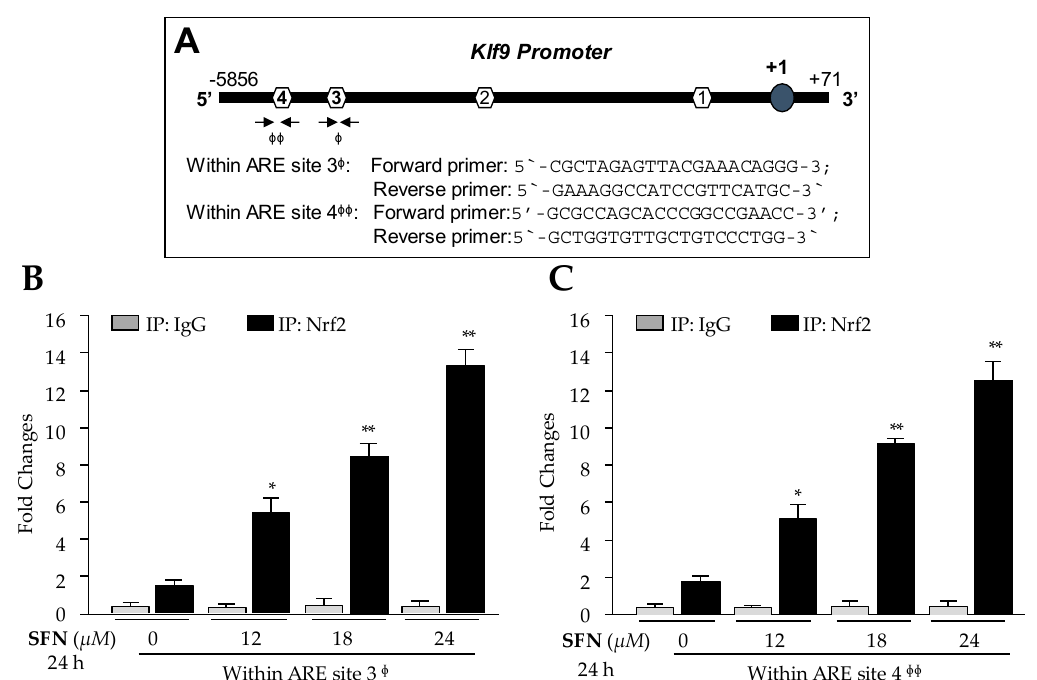
Figure 4. SFN induced increased Nrf2 binding to ARE sites in Klf9 promoter in dose dependent fashion. ( A ) Top panel explaining the presence of four ARE sites in Klf9 promoter and ChIP-qPCR primers containing ARE3 and ARE4. ( B and C ) An in vivo DNA binding assay revealed Nrf2 / ARE interaction. hLECs treated with DMSO control or different concentration of SFN (0, 12, 18 and 24 μ M) for 24 h, as indicated. ChIP assay was carried out with Nrf2 and control IgG antibodies. Pulled DNA fragments were subjected to qPCR analysis. DNA fragments present in the immunoprecipitation were amplified with primers that specifically recognize a fragment of Klf9 promoter containing ARE sites as indicated. As a negative control, ChIP with control IgG was used. * p < 0.05, ** p < 0.001; SFN treated versus DMSO control. Φ and ΦΦ denotes primer pairs used for ChIP-qPCR. Note: Predicted sites ARE1 and ARE2 by in silico analysis are false positive sites (current study and [26]).